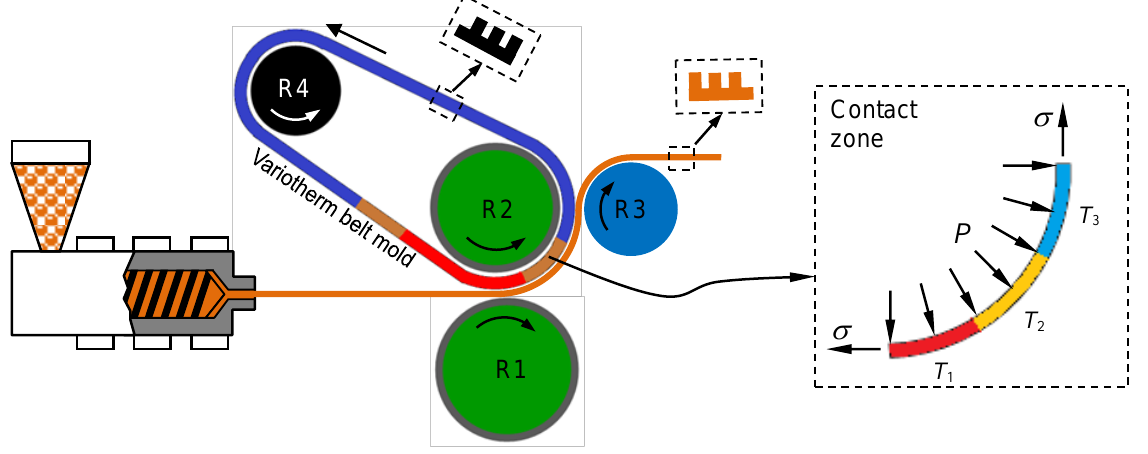
Figure 2. Schematic setup of variotherm extrusion roller imprinting. The extended contact zone is highlighted on the right, showing decreasing temperature from T1–T3, and a pressure applied over the entire contact